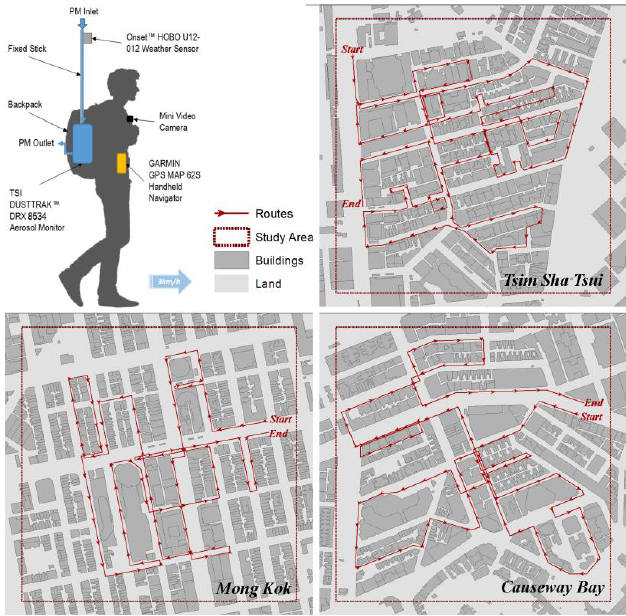
Figure 2. The instrumentation of the backpack measuring unit, and the walking measurement routes in the three selected study areas for measuring the pedestrian-level PM concentration. (The walking measurement routes shown in this figure are labelled based on the forward direction of the